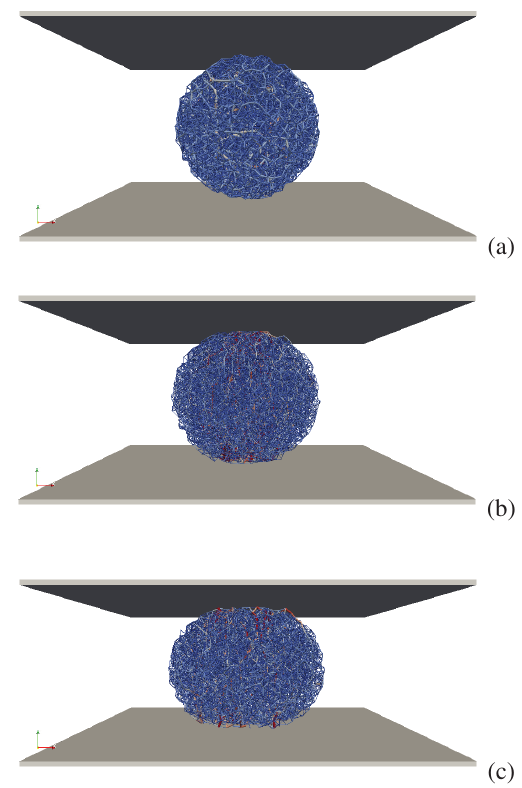
Figure 2. Three snapshots of a granule under diametrical com- pression. The lines represent force chains. The vertical strain ε is calculated from the initial hight h 0 = D of the granule and the total downward displace- ment Δ h .